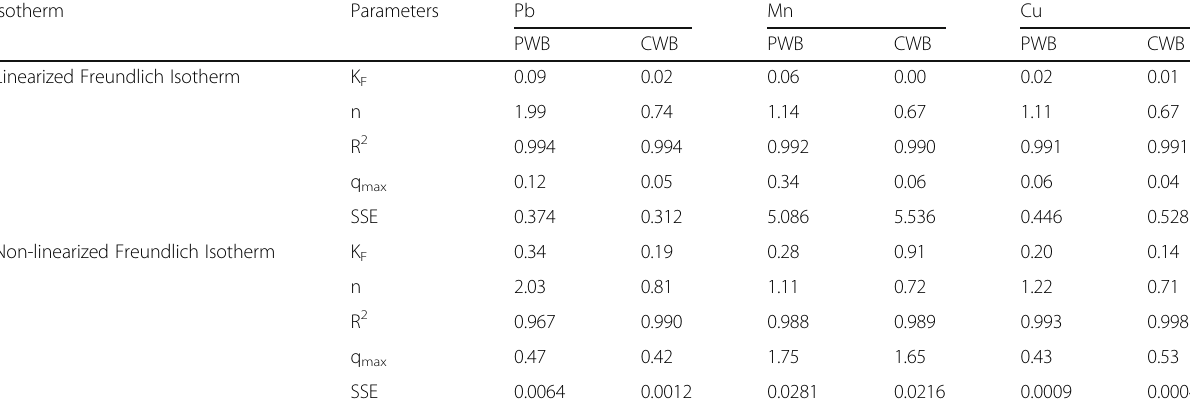
Table 4 Linearized and non-linearized Freundlich isotherm constants for adsorption of Pb, Mn and Cu onto BC Isotherm Parameters Pb Linearized Freundlich Isotherm K